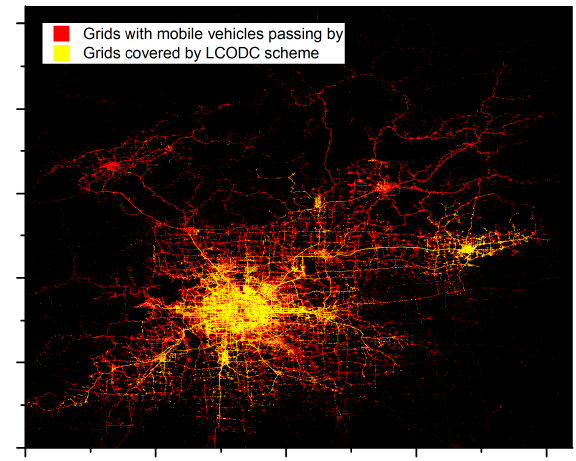
Figure 8. Distribution based on grids covered by uploaded data packets.